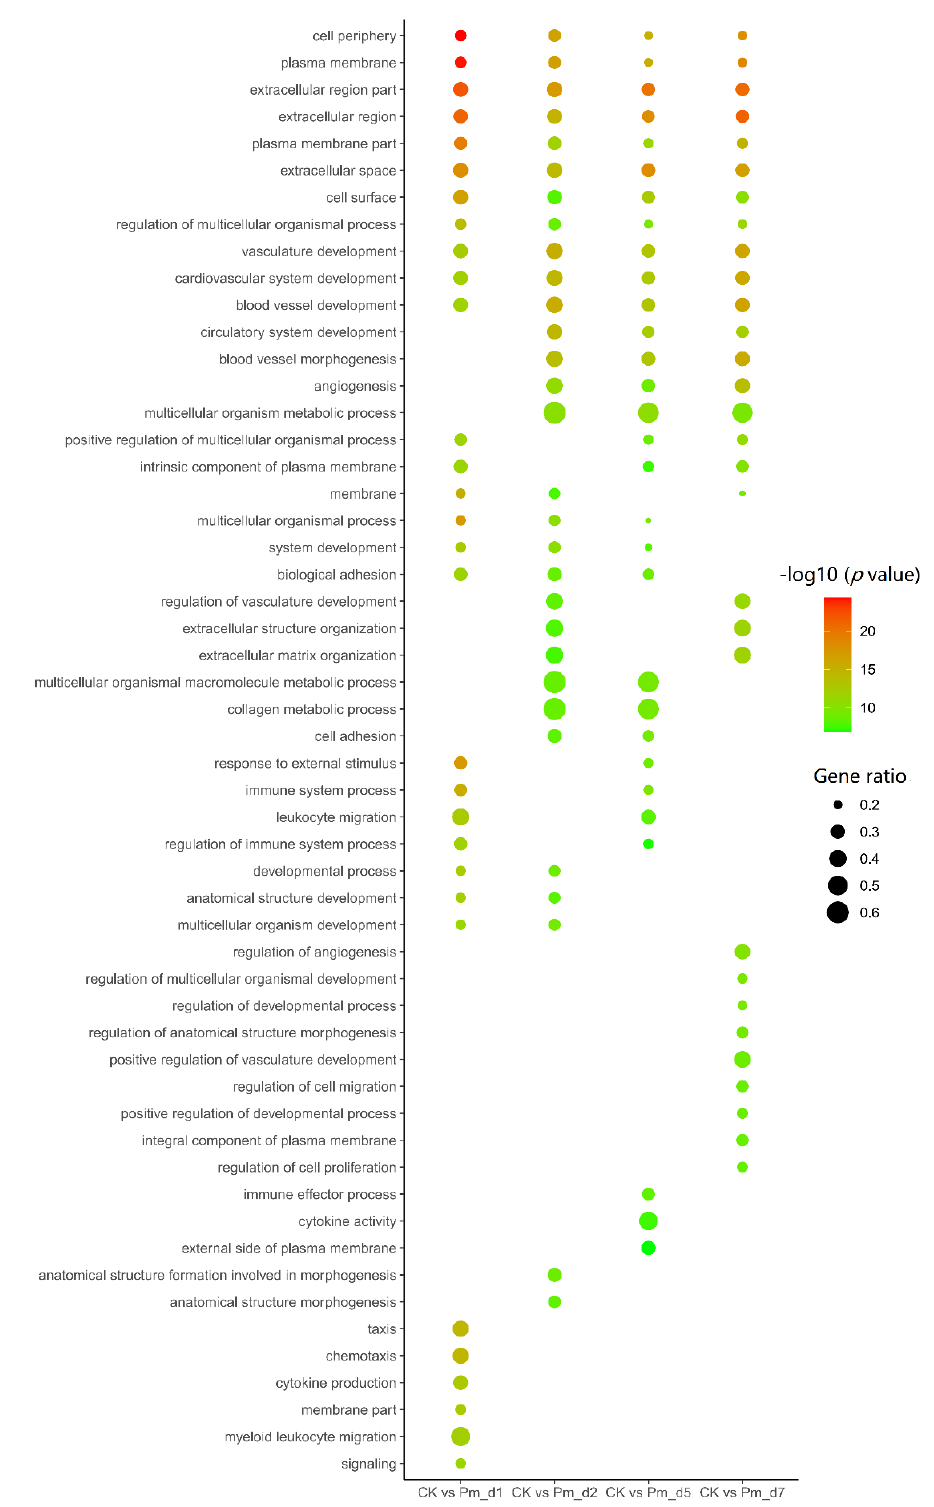
Figure A3. Top 30 enriched GO terms for DEGs in the lung tissues of Pm–challenged goats 1 day, 2 days, 5 days and 7 days compared with the CK group. The x-axis indicates the compared groups, while the names of the GO terms are shown on the y-axis. The size and color of the dot indicate the gene ratio (the number of differentially expressed genes/total genes for each GO term) and the −log10 ( p - value) (Fisher’s exact test), respectively.